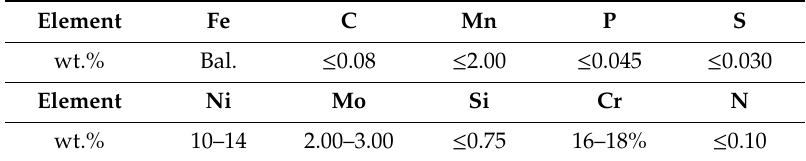
Table 1. Chemical composition of the SS316 stainless